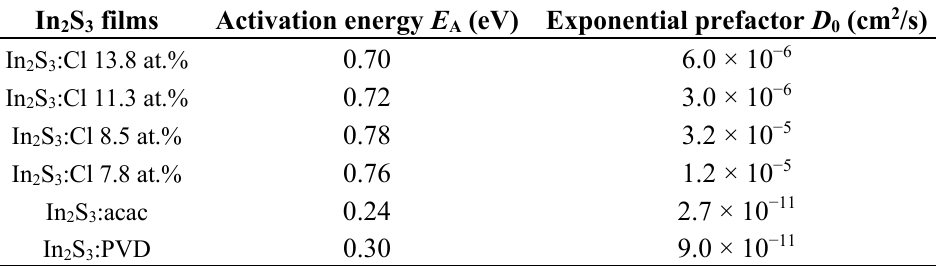
Table 2. Activation energy and exponential prefactor of In 2 S 3 films with varying chlorine